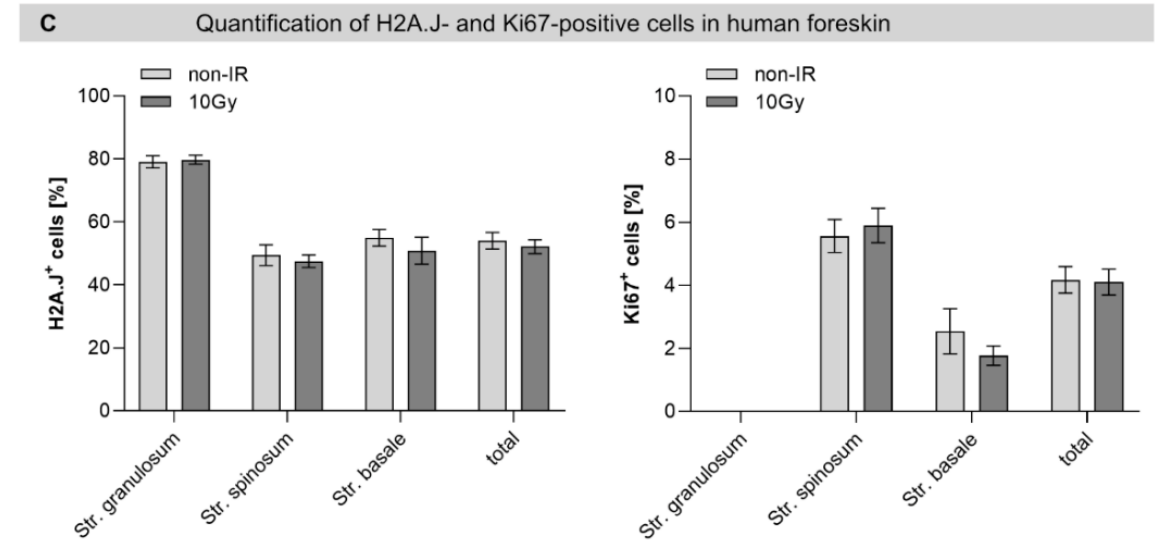
Figure 1. H2A.J and Ki67 expression in foreskin explants after ex vivo IR exposure. ( A ) IHC micrographs of H2A.J staining in foreskin explants after IR exposure (10 Gy; 24 h post-IR) compared to non-irradiated control. ( B ) IF micrographs of H2A.J and Ki67 double-staining in foreskin explants after IR exposure (10 Gy; 24 h post-IR) compared to non-irradiated control. Top photos contain DAPI signals, and bottom photos show the same photos but without corresponding DAPI signals so that the different H2A.J staining intensities (green signal) in the epidermis become more visible. ( C ) Graphic presentation of the quantification of H2A.J+ and Ki67+ cells in epidermis of foreskin explants. Data are presented as mean ± SD ( n = 12).